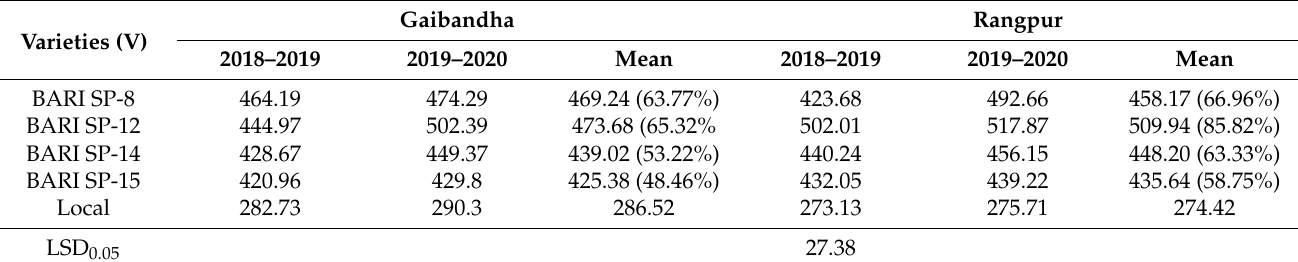
Table 6. Interrelation impacts of variety (V), Year (Y) and environment (E) on average root weight plant − 1 (g) of sweet potato. Gaibandha Rangpur Varieties (V)